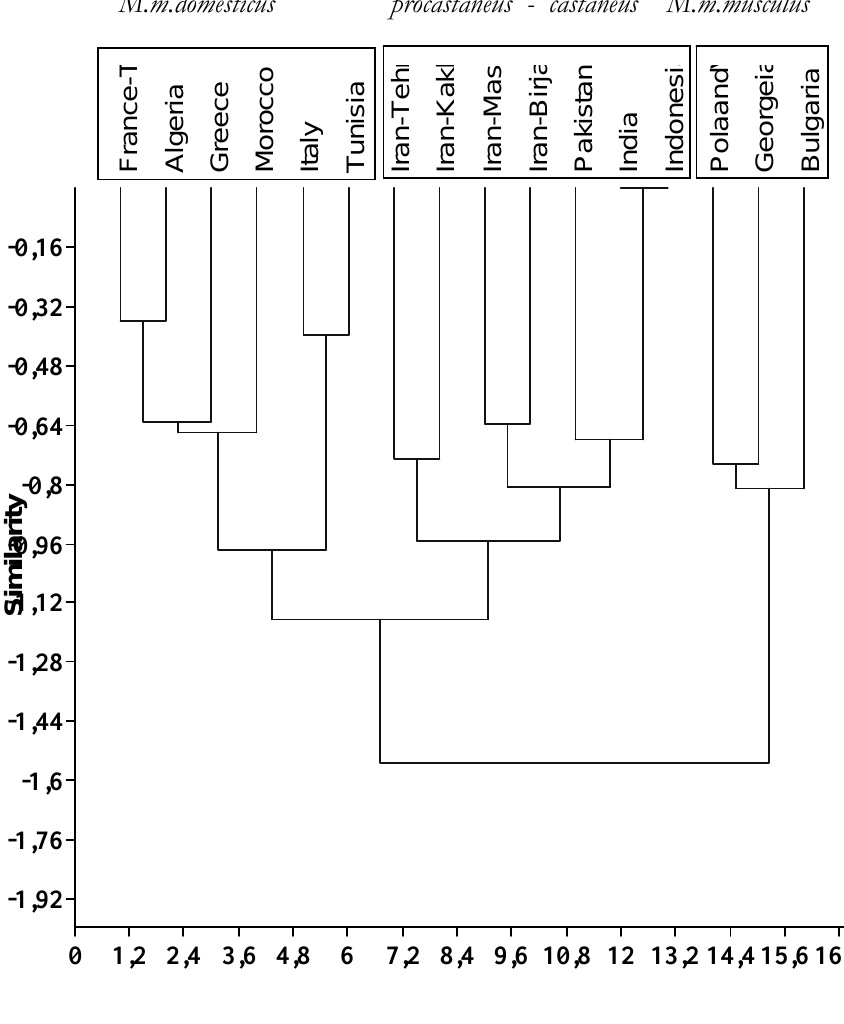
F IG .5- Clustering of morphometric centroid of all sample extracted from Canonical Discriminant